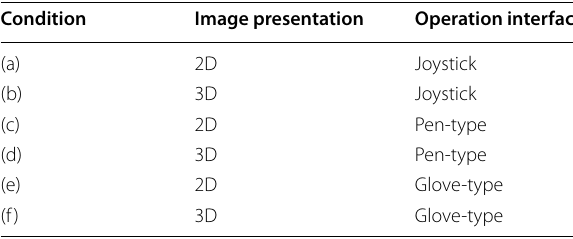
Table 1 Experimental conditions Condition